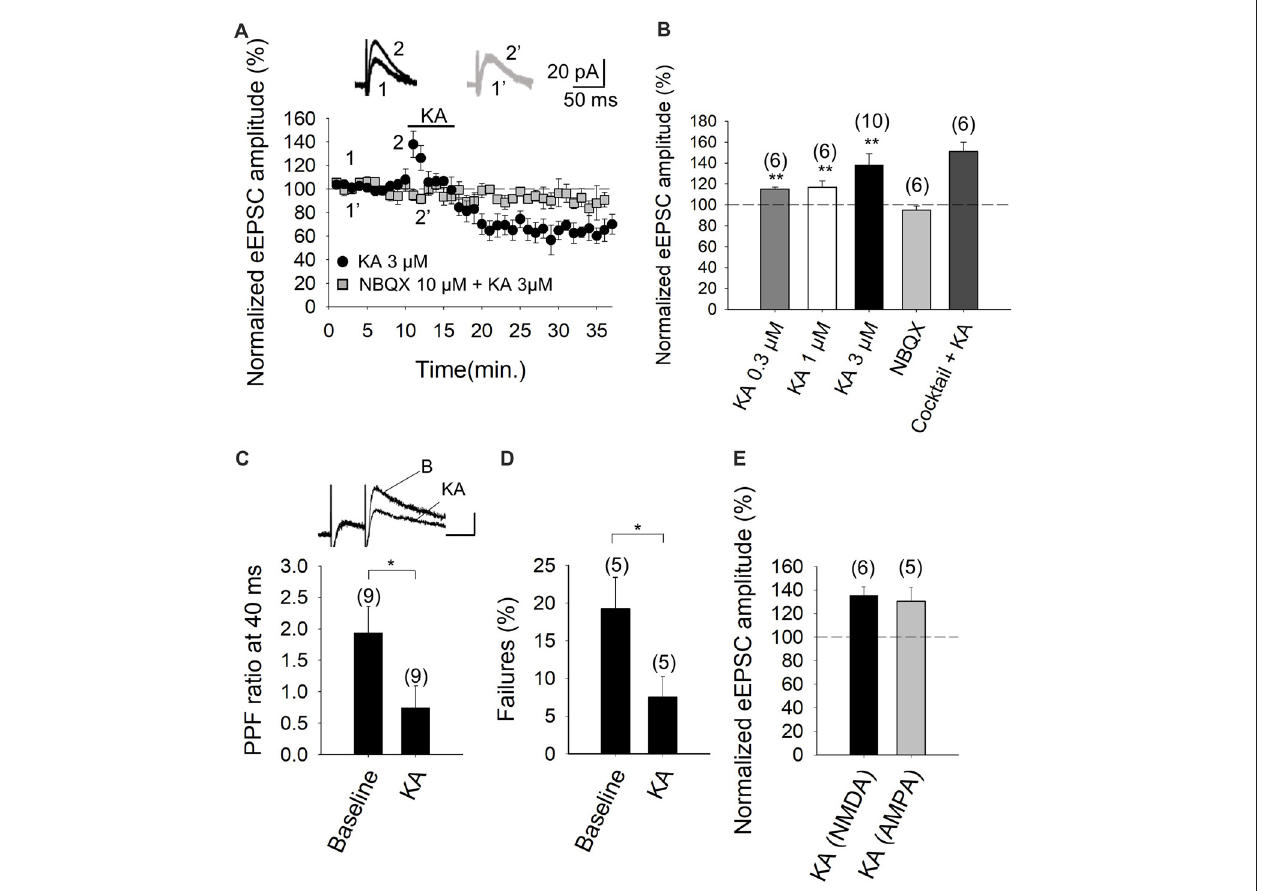
FIGURE 1 | Kainate (KA) increases the evoked excitatory postsynaptic currents (eEPSCs) amplitude at parallel fibers-Purkinje cells (PF-PuC) synapses of the cerebellum. (A) Time course of KA (3 µ M) effect on eEPSCs amplitude in the absence (circles) and presence of NBQX (squares). Inset show traces before and after 4 min KA perfusion in the absence (1, 2) and in the presence of 10 µ M NBQX (1 (cid:48) , 2 (cid:48) ). (B) Quantification of modulation observed in (A) and dose dependency. (C) KA (3 µ M) perfusion produces a decrease of the paired pulse ratio, inset shows scaled representative traces. (D) Effect of KA on the number of failures of NMDA receptor-mediated currents. (E) Effect of KA (3 µ M) on NMDA and AMPA receptor-mediated currents, respectively. Note that the effect of kainate on these currents is indistinguishable. The number of slices (from two to three mice) is indicated in parenthesis at the top of each bar. Results are expressed as means ± SEM ( ∗ P < 0.05, ∗∗ P < 0.01, Student’s t -test).